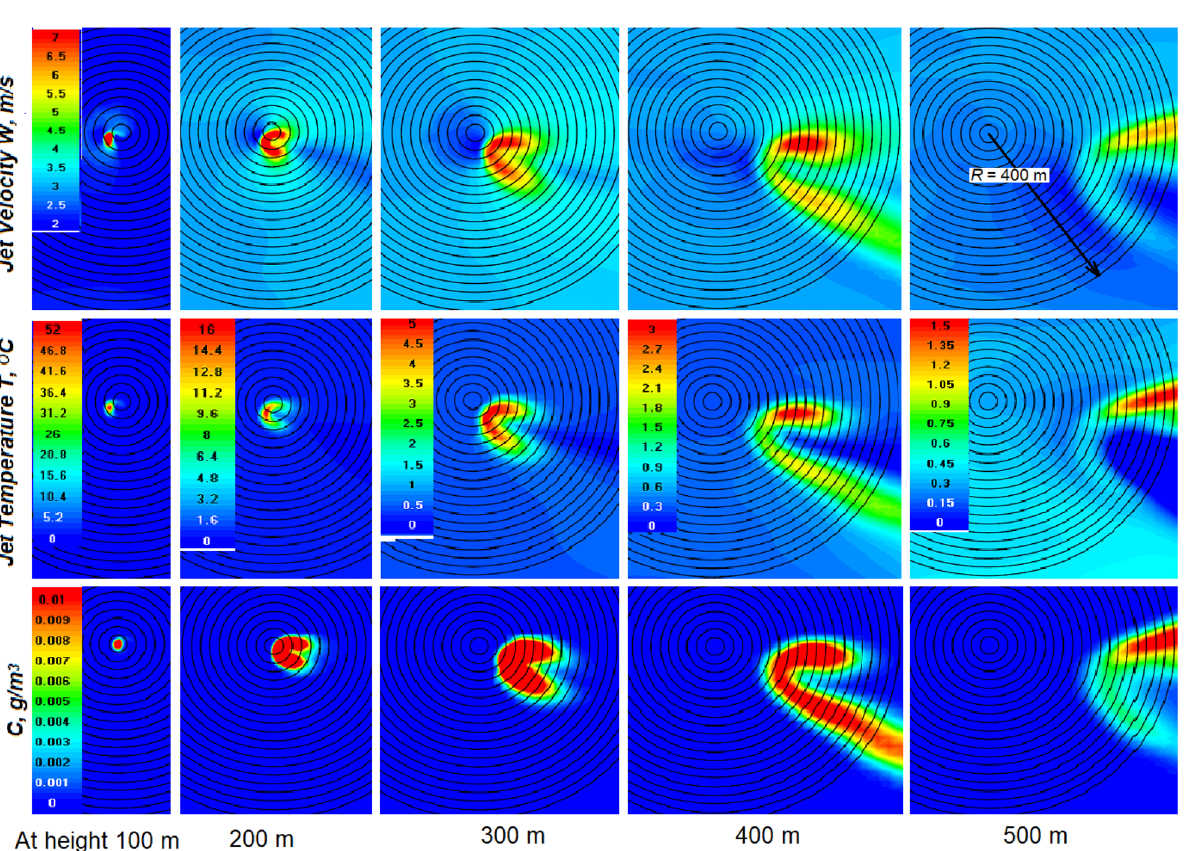
Figure 12. Horizontal sections of the W , T and C fields at the indicated heights in the presence of wind U = 1 m/s, γ = 6.5 °C/km and f =